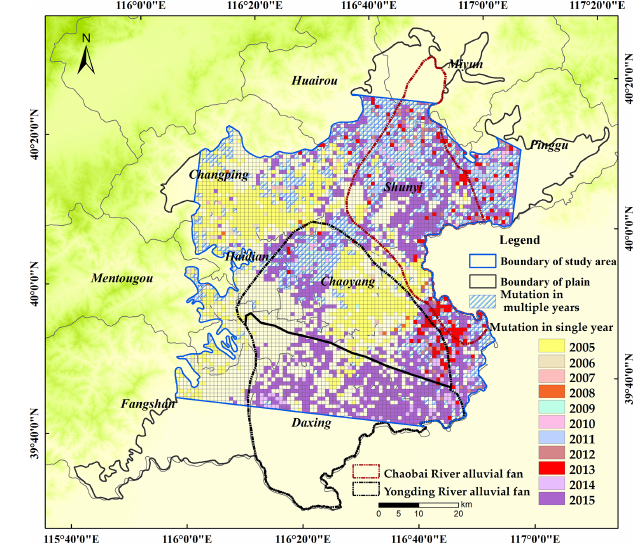
Figure 5. Land subsidence changes (land subsidence rate) results for the Beijing Plain from 2004 to